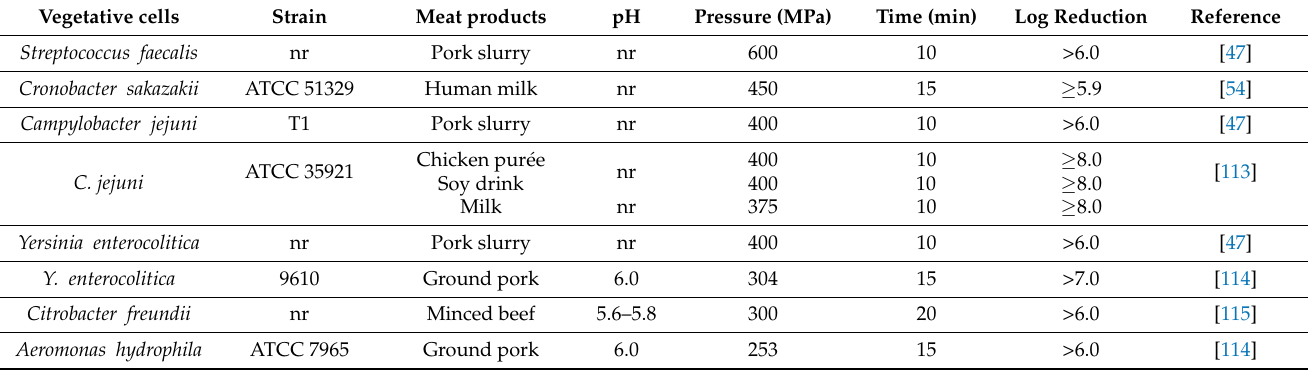
Table 6. Inactivation of other pathogenic vegetative cells in meat products by high pressure processing (HPP)